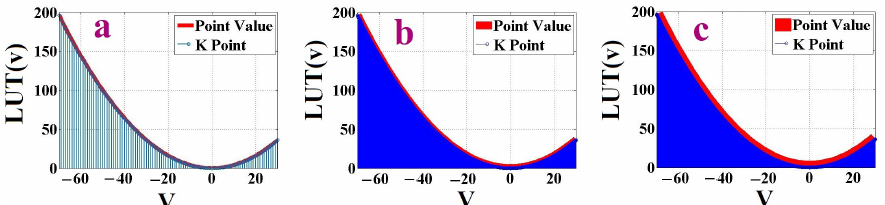
Figure 2. Creating the LUT ( v ) function with different levels of sampling. ( a ) Estimating the LUT ( v ) function by 100 points. ( b ) Estimating the LUT ( v ) function by 1000 points. ( c ) Estimating the LUT ( v ) function by 10,000 points.